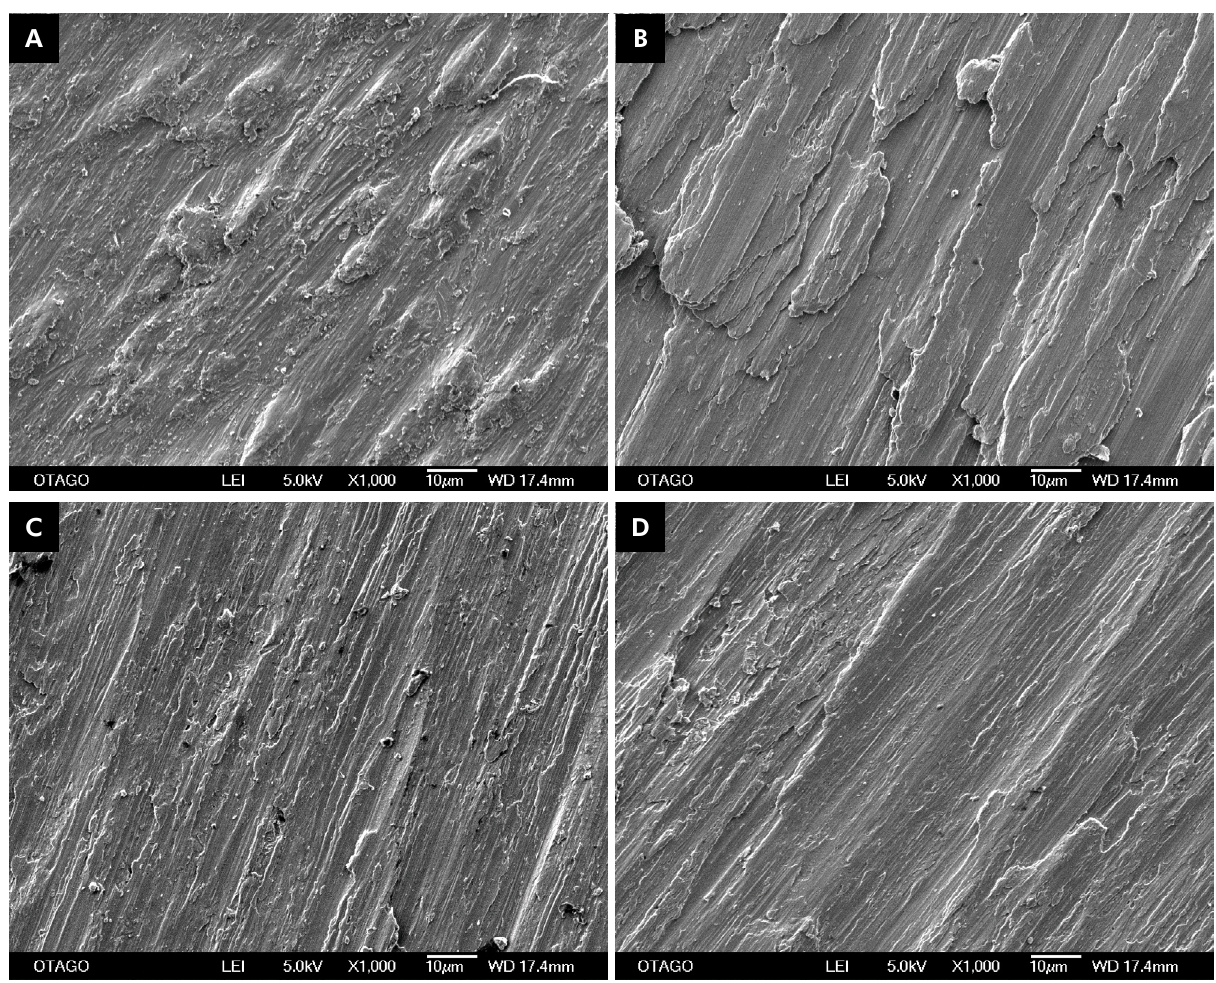
Figure 5. Moderately roughened disk surfaces following the corresponding steps of instrumentation (x1000 magnification) a) Step 1 of TPP b) Step 2 of TPP c) Step 3 of TPP d) Step 4 of